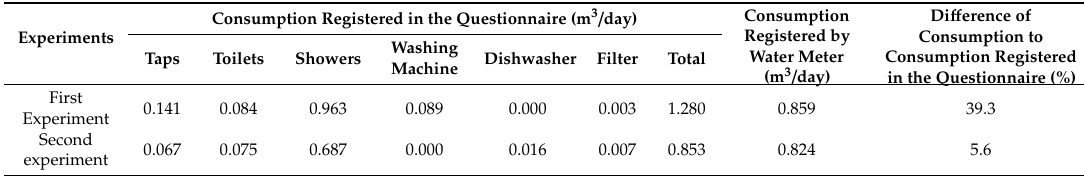
Table 4. Results obtained in the first two experiments (pilot experiments).